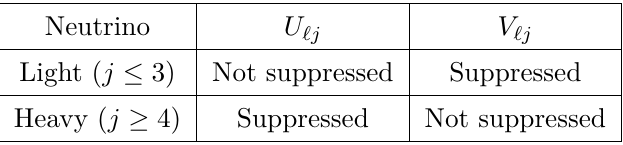
Table 2. Suppression of the mixing matrix